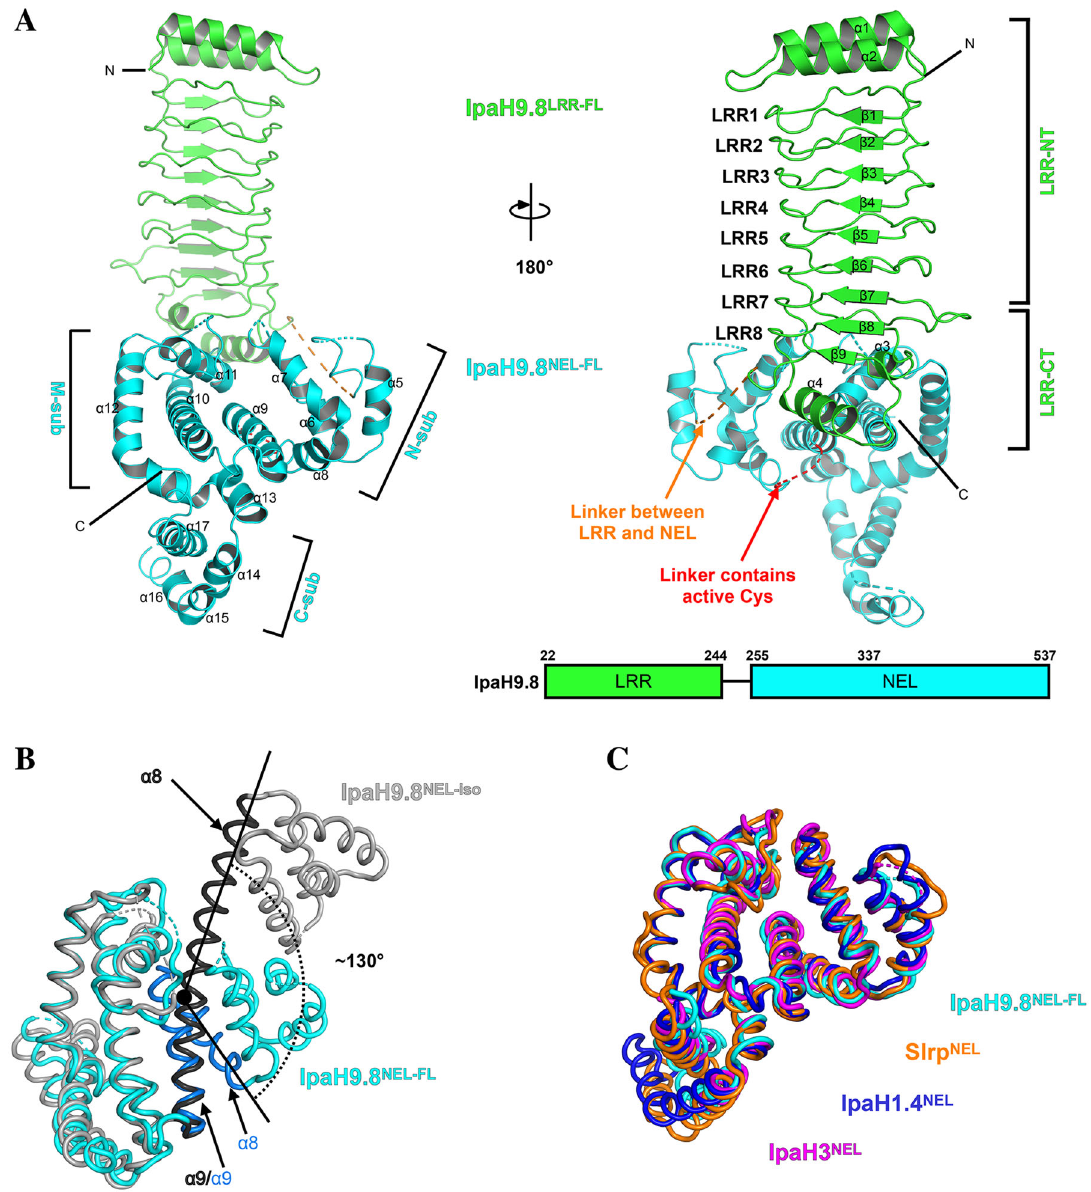
Fig. 1 Overall structure of IpaH9.8. A Top, schematic representations of the IpaH9.8 constructs used for crystallization. The LRR domain is colored green and the NEL domain cyan. Left, a cartoon model of near full-length IpaH9.8 with domains colored as described above. Three NEL subdomains (N-sub, M- sub, and C-sub) and the α -helixes ( α 5 – α 17) in NEL are indicated. Right, cartoon representation of IpaH9.8 as in left but rotated ~180° with the LRR motifs, LRR-NT, and LRR-CT labeled. The α -helixes ( α 1 – α 4) and the β -sheets ( β 1 – β 9) in LRR are indicated. Linkers without a determined structure are indicated by dashed lines with the linker between LRR and NEL colored orange, while the linker containing the active Cys residue is colored red. B Superposition of IpaH9.8 NEL-FL (cyan) and IpaH9.8 NEL-iso (PDBID: 3L3P, gray) structures. The helixes α 8/ α 9 in IpaH9.8 NEL-FL and IpaH9.8 NEL-iso are labeled and colored blue and black, respectively. The α 8/ α 9 bends ~130° in IpaH9.8 NEL-FL but adopts a straight α -helical conformation in IpaH9.8 NEL-iso . C Superposition of IpaH9.8 NEL-FL (cyan), Slrp NEL (PDBID: 4PUF, orange), IpaH1.4 NEL (PDBID: 3CKD, blue) and IpaH3 NEL (PDBID: 3CVR, magenta)